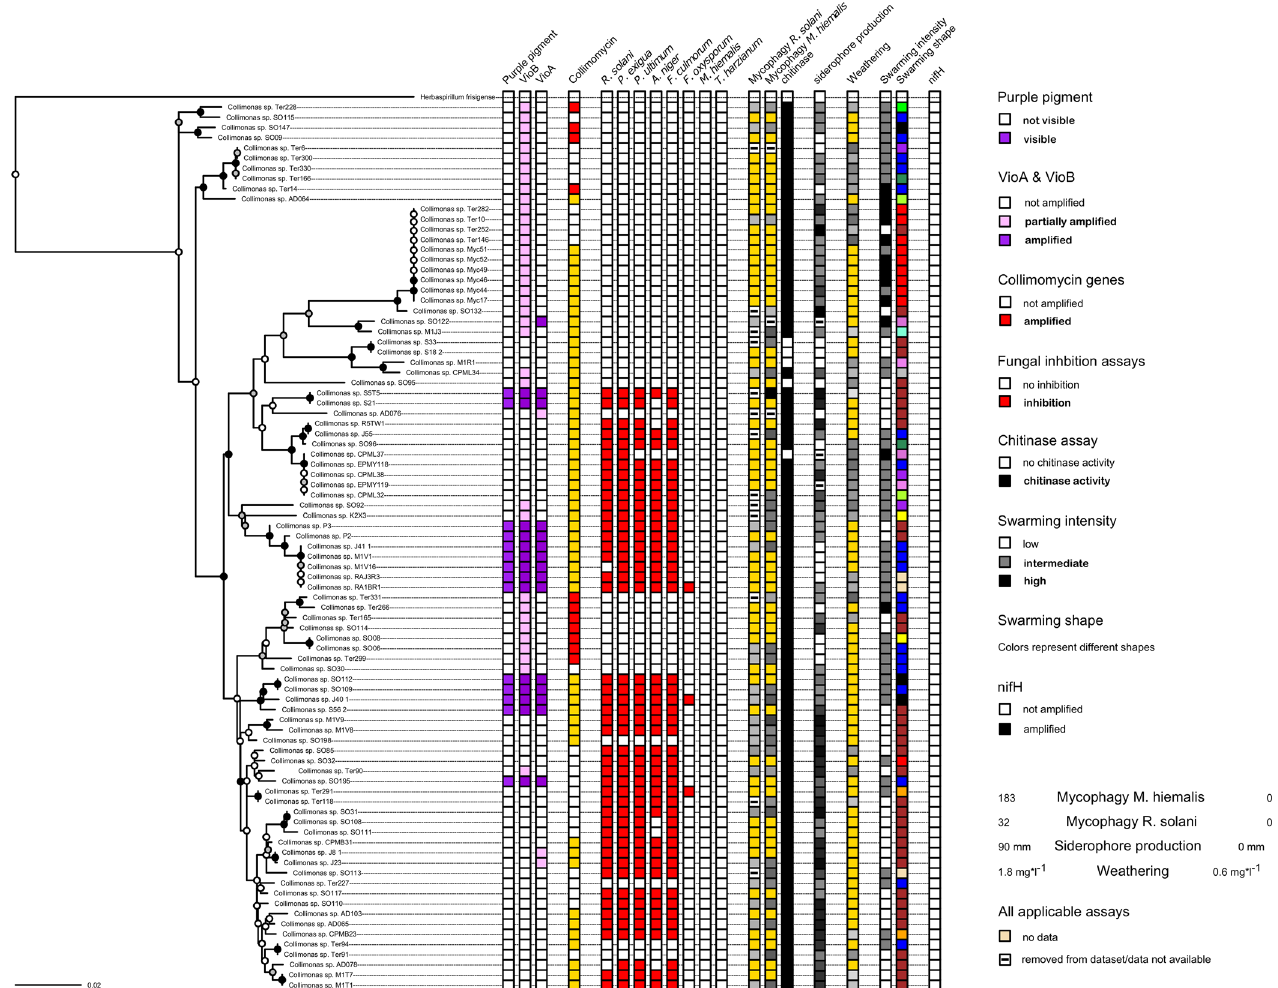
Fig 2. Overview on grouping of collected trait data with the concatenated housekeeping gene phylogeny. The tree was tested with 100 bootstraps, nodes with white circles represent bootstrap support values lower than 50, grey higher than 50 and black higher than 75. doi:10.1371/journal.pone.0157552.g002 PLOS ONE | DOI:10.1371/journal.pone.0157552 June 16,